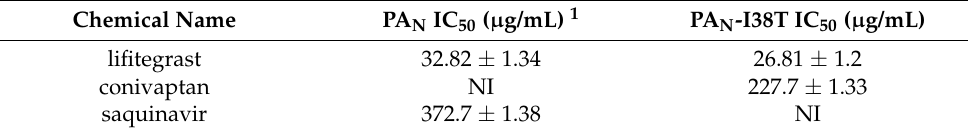
Table 1. IC 50 values of compound inhibited PA N and PA N -I38T